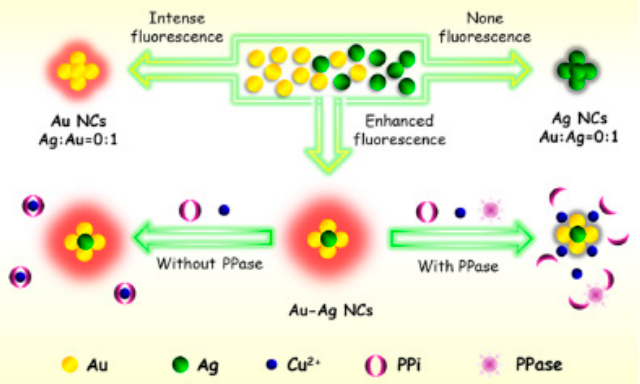
Figure 16. Schematic illustration of gold-silver bimetallic nanocluster (Au-Ag NCs) based fluorescent probes for quantitative monitoring of inorganic pyrophosphatase (PPase) activity coupling enzyme-induced hydrolysis of pyrophosphate ion (PPi, P 2 O 74 − ) with the release of copper ion (Cu 2+ ) from the Cu 2+ -PPi complexes (Copyright Ref [183], American Chemical Society).